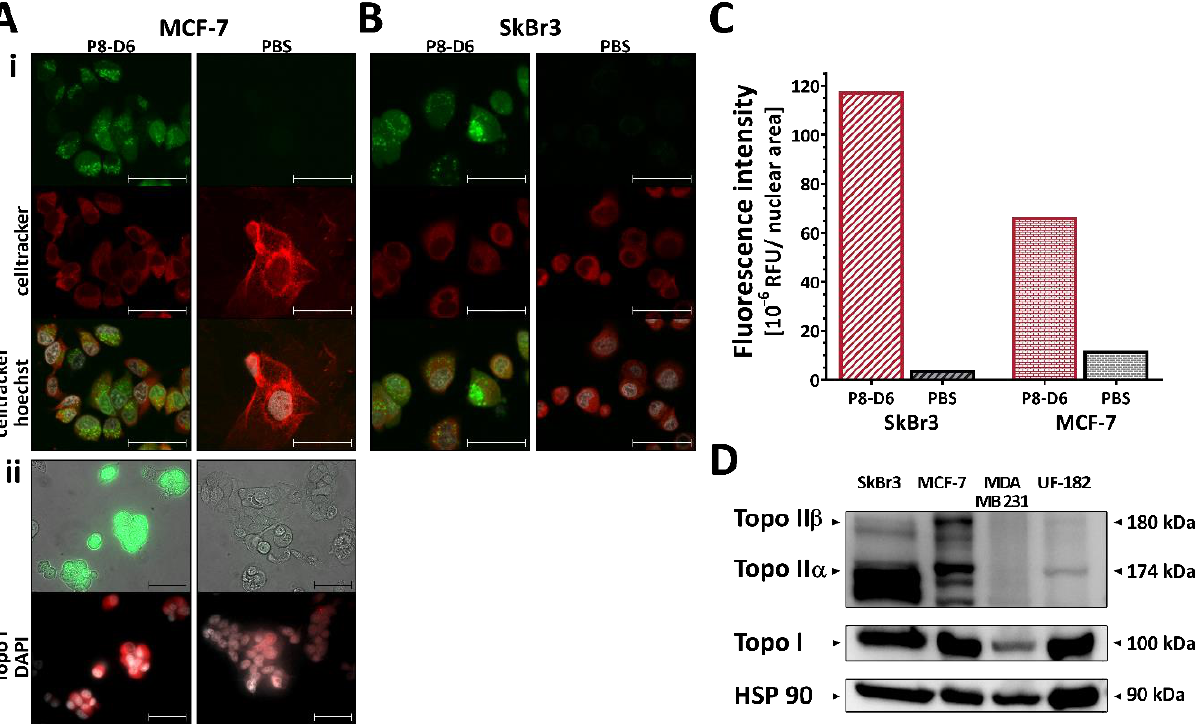
Figure 2. Target control. MCF-7 ( A ) and SkBr3 ( B ) cells were treated with 10 µ M P8-D6 (fluorophore: 462Ex/530Em) or control (PBS) for 10 h. P8-D6 were localized in vitro. ( i ): Cells were stained by CellTracker TM Deep Red Dye and Hoechst 33342. ( ii ) After fixation, topoisomerase I were detected. Fluorescence images show the fluorophore P8-D6 in green, membrane staining ( i ) or topoisomerase expression ( ii ) in red and nucleus staining in white. Scale bars, 50 µ m. ( C ) Fluorescence intensity of P8-D6 in the nuclei was compared to PBS control. ( D ) BC cell lines and primary cells were lysed and protein expression was analyzed using western blot. HSP 90 was used as loading control.